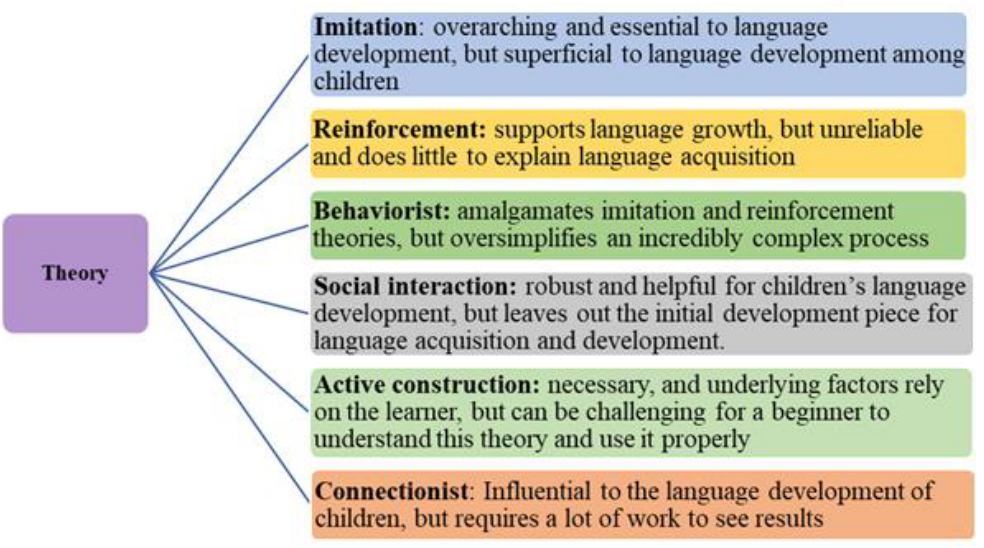
Figure 1. In- service Teachers’ Perception of First Language Acquisition